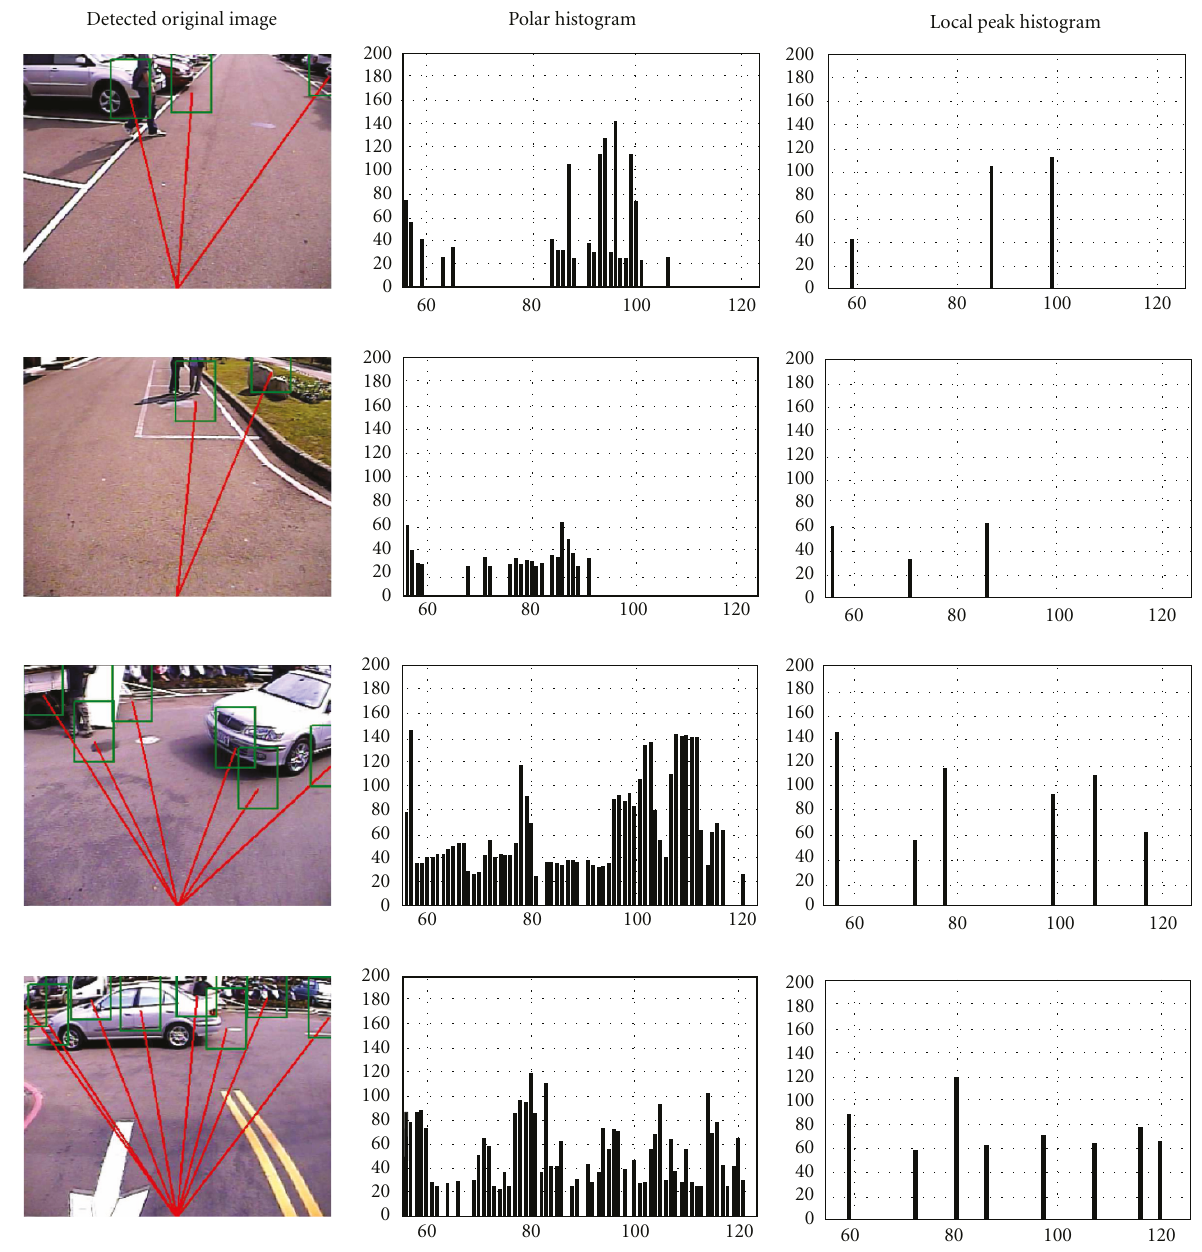
Figure 27: Results of obstacle warning with moving objects. Upper two rows are the results with moving humans. Bottom two rows are the results with a moving vehicle turning into the